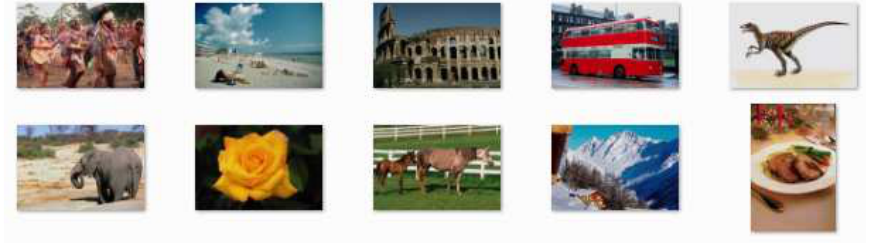
Figure 5. Ten classes on Corel-1000 dataset.